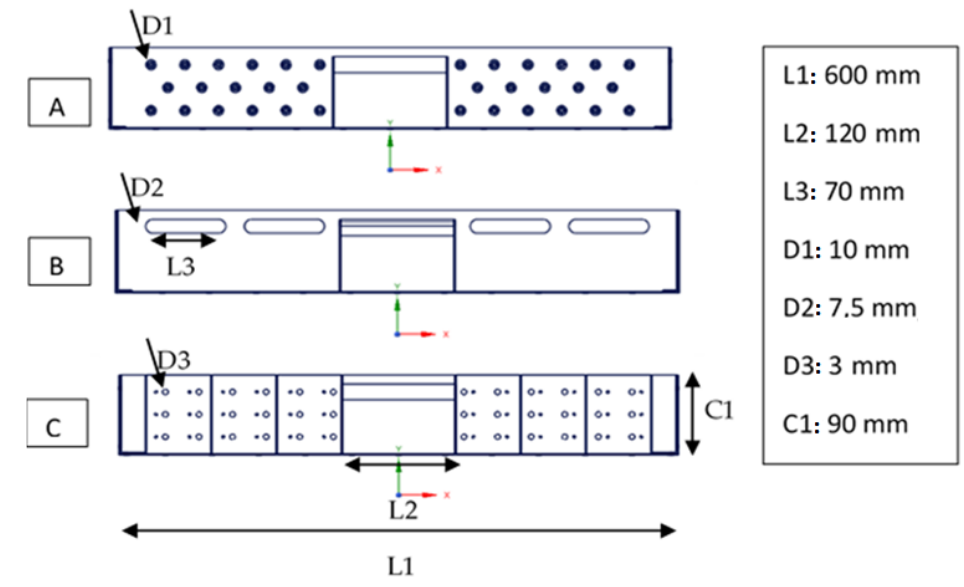
Figure 1. Positions and dimensions of the air vent holes on each package configuration.